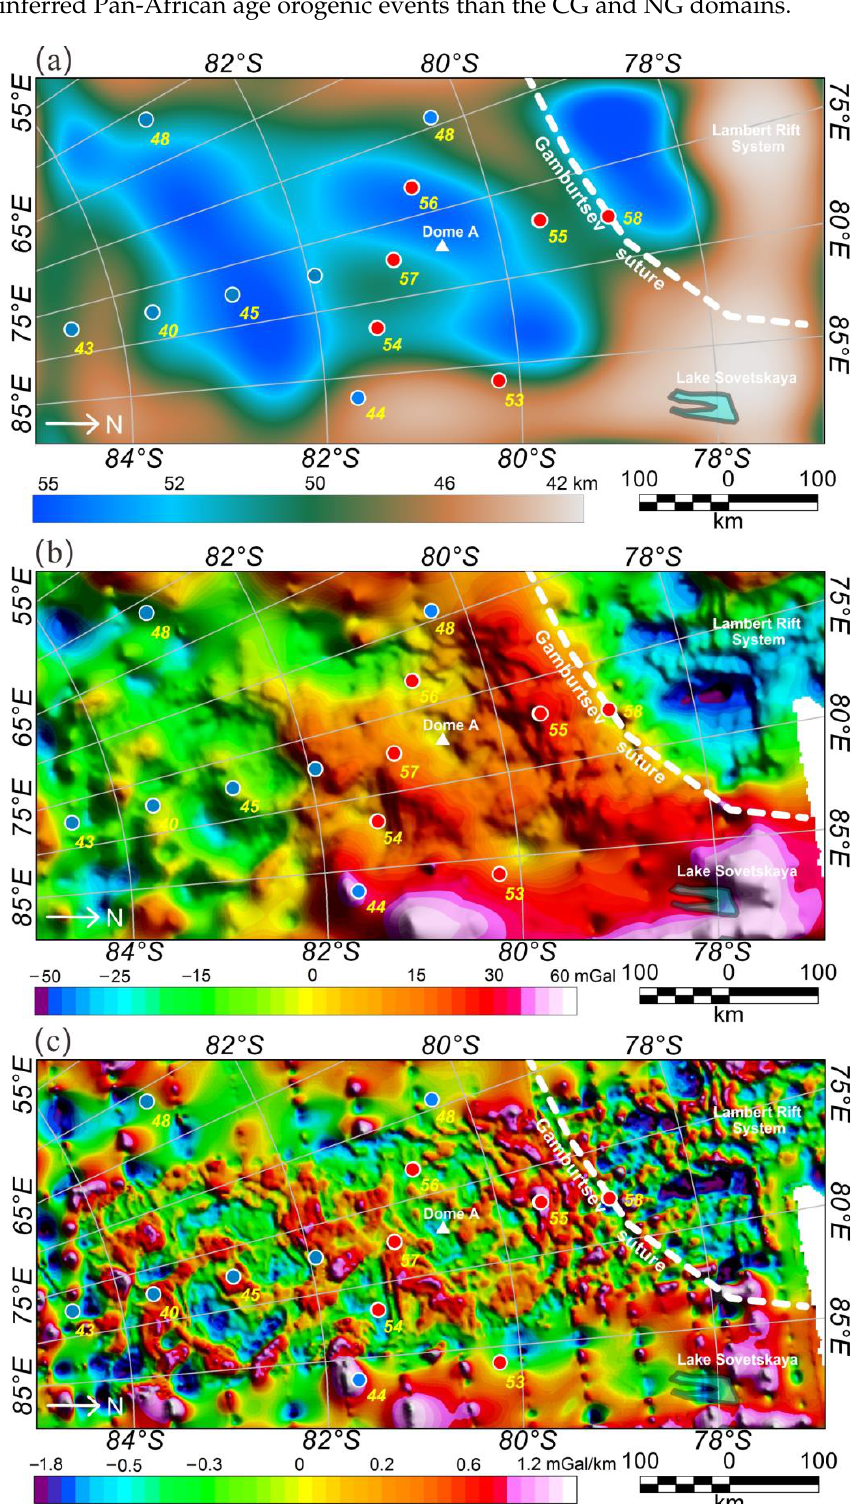
Figure 3. Airborne gravity data processing and interpretation of the GSMs. ( a ) Crust thickness map of the GSMs inversed from Bouguer Gravity data. ( b ) Isostatic residual gravity anomaly map of the GSMs. The reduced height is 4600 m above the sea-level. The isostatic residual gravity was